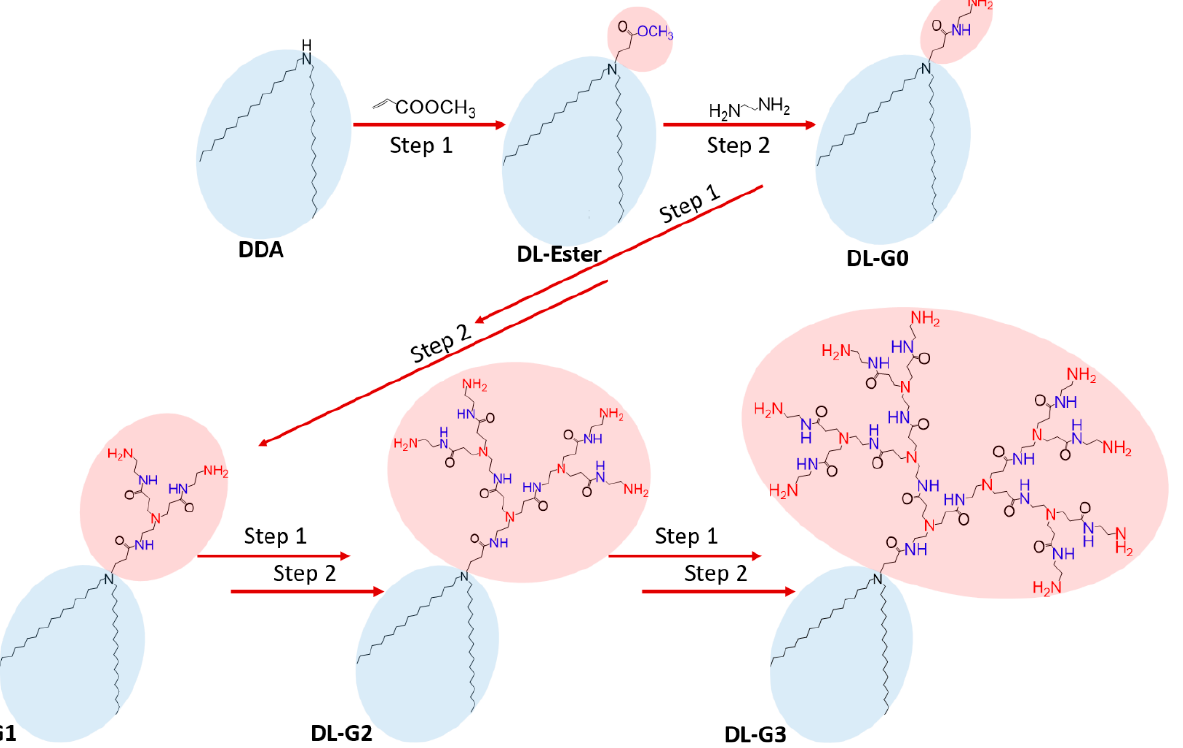
Figure 6. Synthetic Route of PAMAM Dendron-Bearing Lipids .